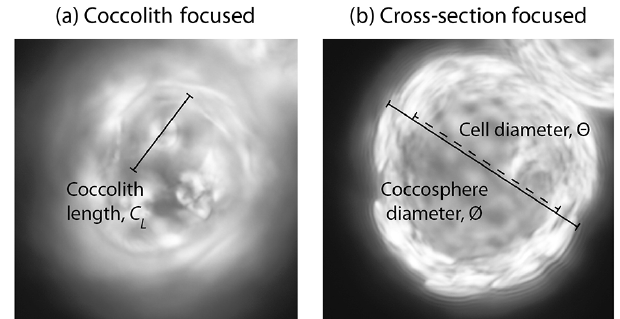
Figure 1. Light microscope image of a C. quadriperforatus cocco- sphere, illustrating the coccosphere geometry terminology used in this study and the size measurements made on each individual coc- cosphere. After counting the number of coccoliths per cell ( C N ) , images are taken of (a) an in-focus, representative coccolith on ei- ther the top or bottom surface of the coccosphere from which coc- colith length ( C L ) is measured, and (b) a cross-sectional view from which the coccosphere diameter ( ∅ ) and internal coccosphere di- ameter, assumed to represent cell diameter ( (cid:50) ), are